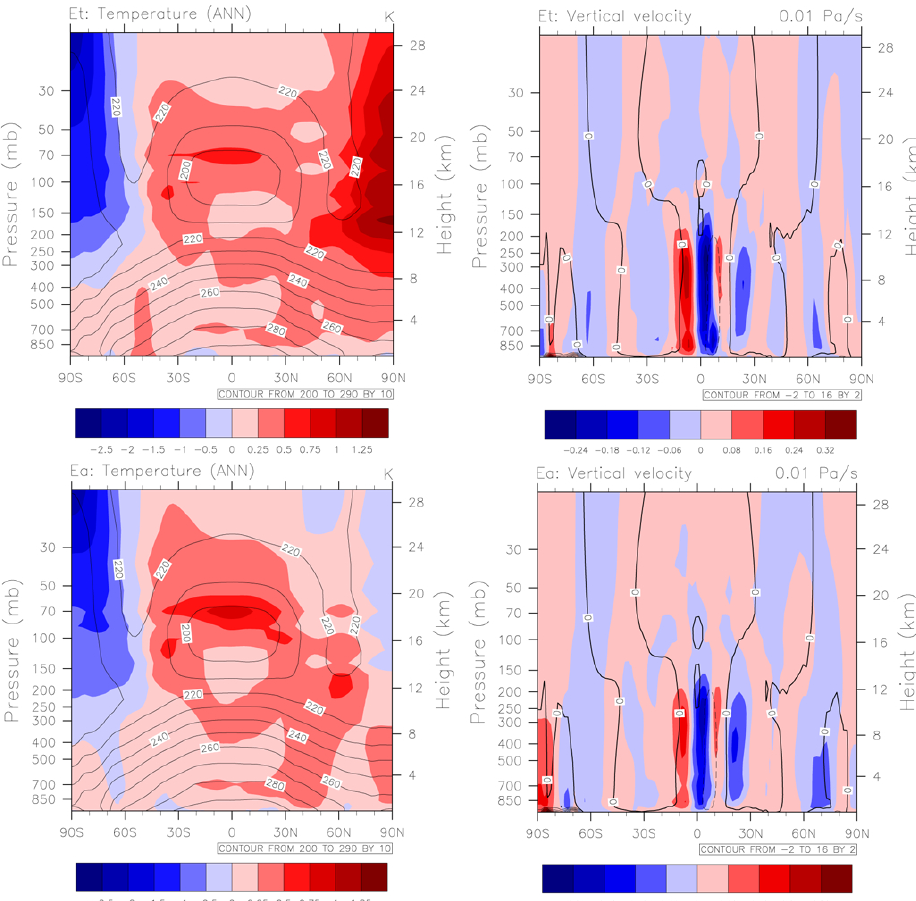
Fig. 7. Vertical profiles of zonal mean changes in temperature (left column) and omega fields (right column) for Et and Ea. Color shading denotes changes and black contour lines represent climatology based on the no-carbon